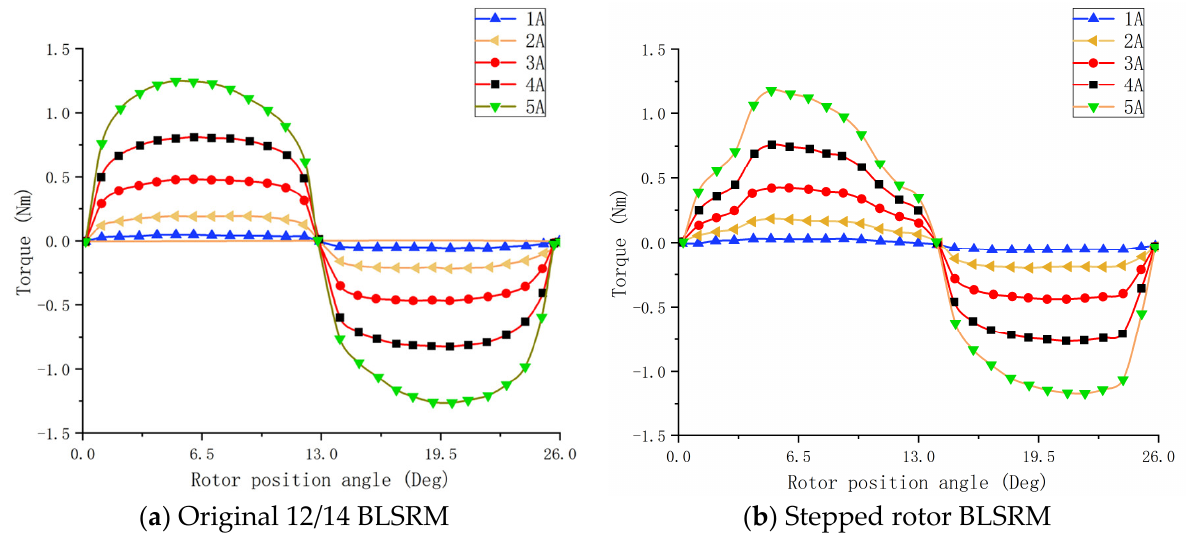
Figure 17. Torque characteristic curve of torque windings.